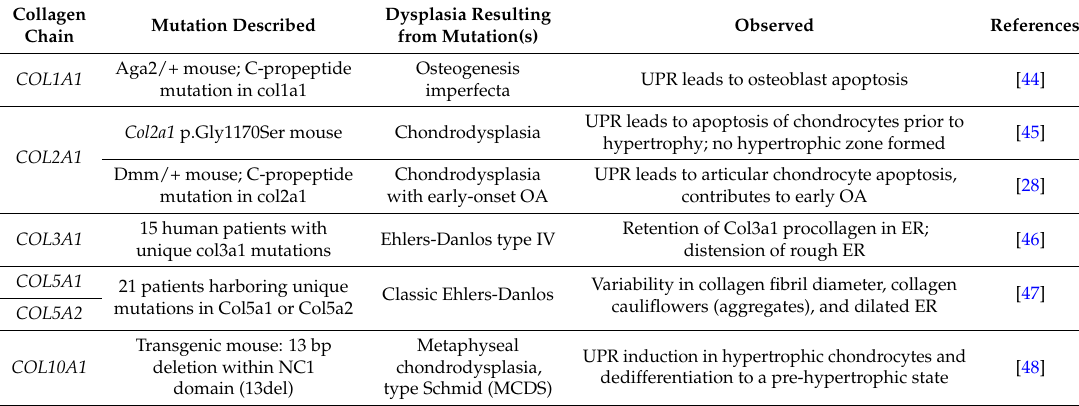
Table 1. Mutations in collagen genes that may induce ER stress/UPR and lead to